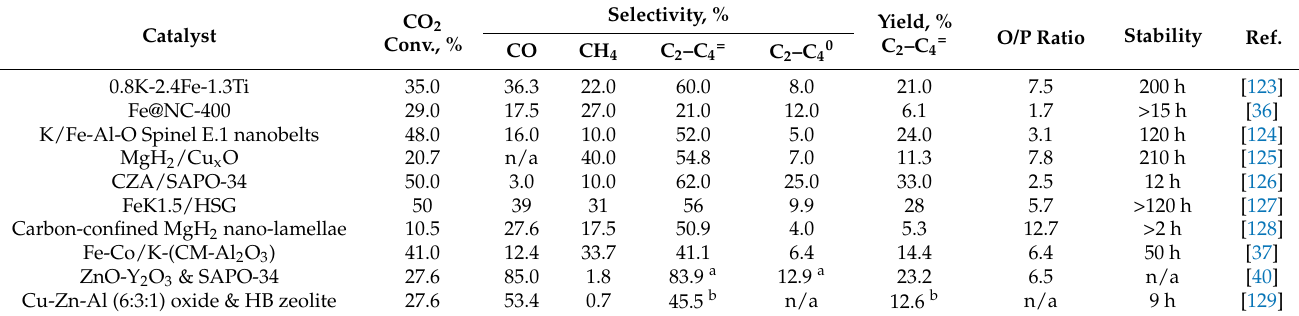
Table 4. Some representative catalysts on the structure effect for CO 2 hydrogenation to light olefins. Selectivity, % Yield, % CO 2 Catalyst Conv., % C 2 –C 4 = O/P Ratio